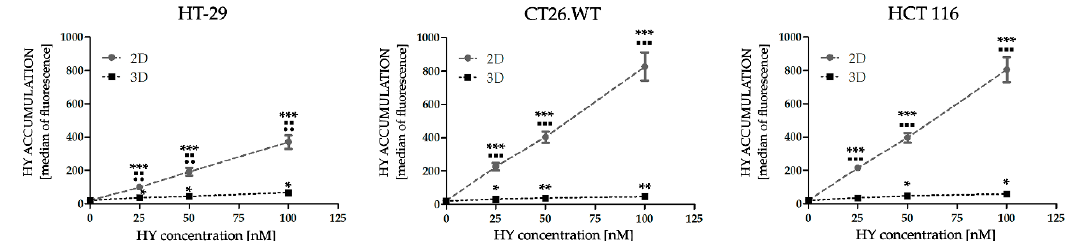
Figure 3. Comparison of intracellular accumulation of hypericin (HY) in 2D and 3D cell models. The incorporation of HY in all cell lines was analyzed 16 h after treatment. The results are expressed as the mean value ± SD of three independent experiments. The experimental groups cultivated in 2D and 3D cell models were compared with the control group (* p < 0.05, ** p < 0.01, *** p < 0.001). The experimental groups cultivated in 2D cell models were compared with experimental groups cultivated in 3D cell models ( ▪ p < 0.05, ▪▪ p < 0.01, ▪▪▪ p < 0.001). HT-29 cells cultivated in 2D and 3D cell model were compared with other two experimental cell lines (•• p < 0.01).